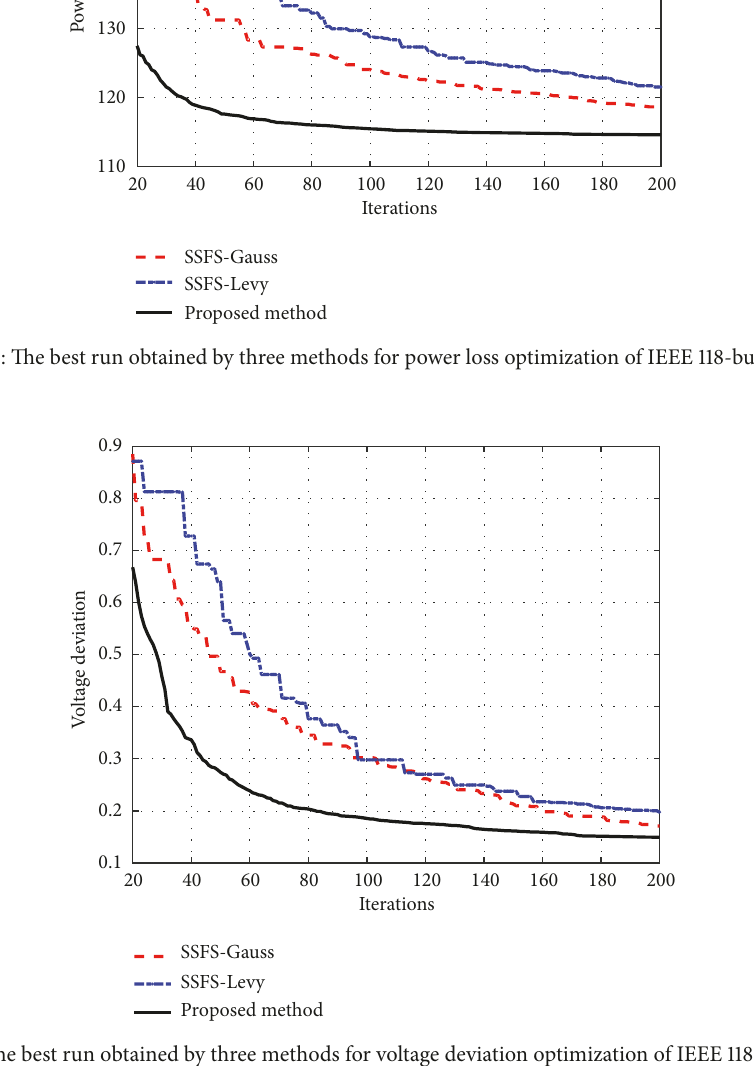
of FAHCLPSO is 6.8372MW but that of MFOT is still